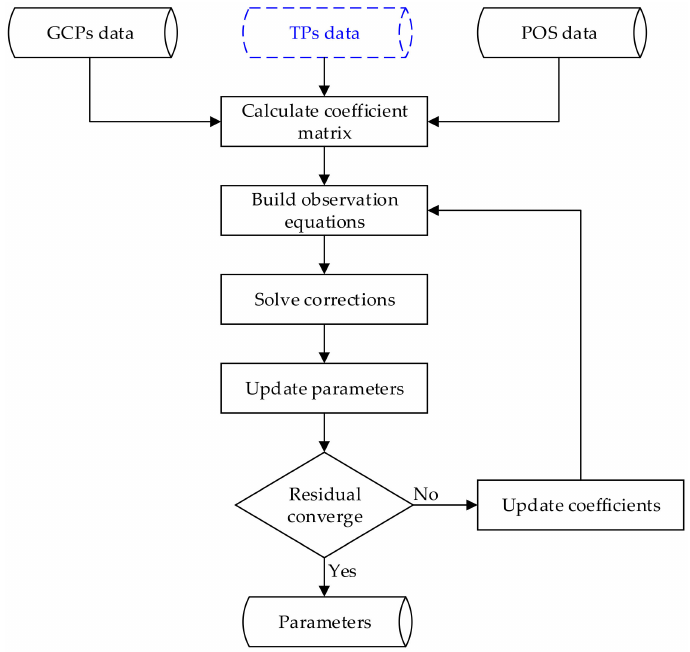
Figure 6. The processing flow of block